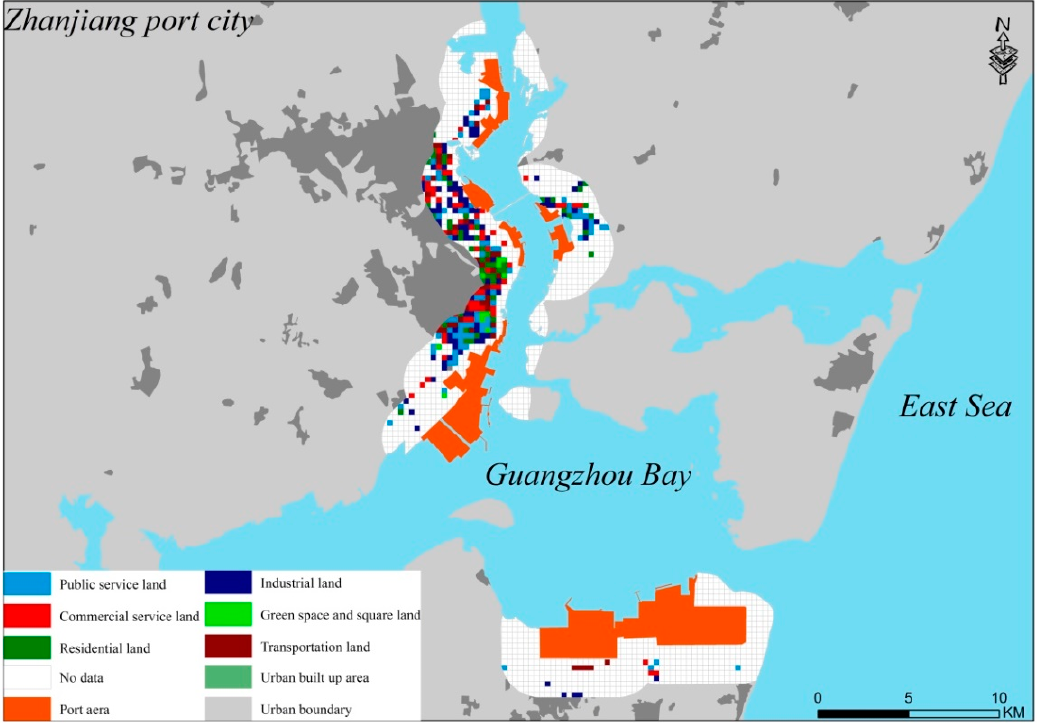
Figure 12. Distribution of urban functional areas on the Zhanjaing port–city interface (source: drawn by author).